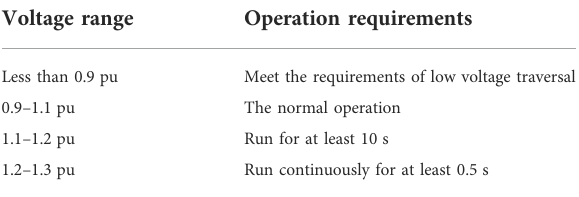
FIGURE 11 DG is connected to bus A at the beginning of feeder.